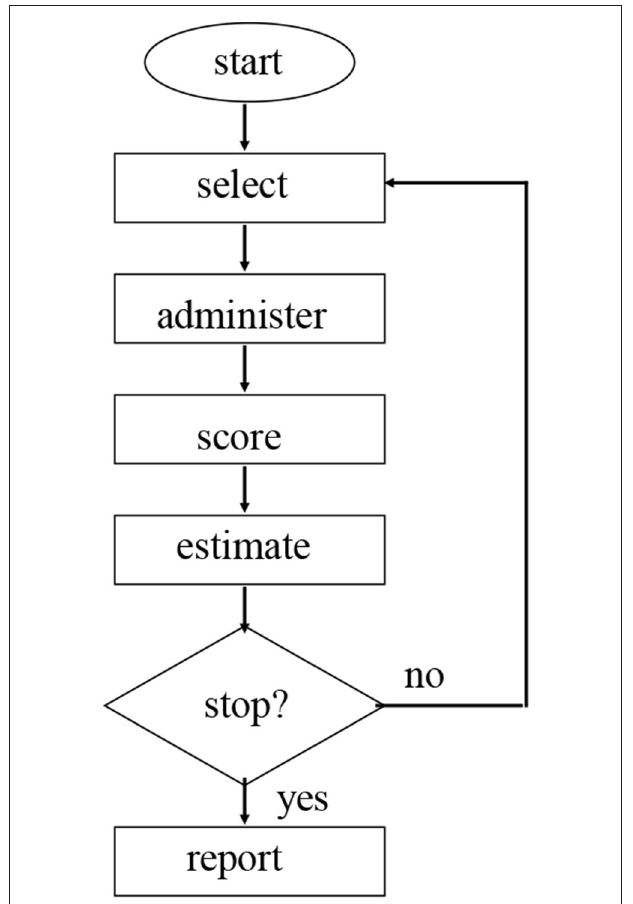
FIGURE 1 | Schematic representation of an adaptive